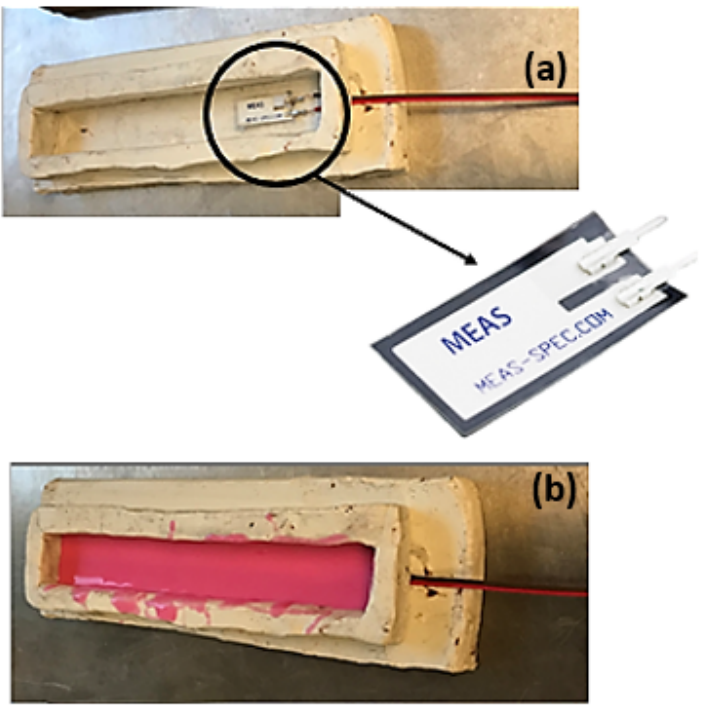
Figure 11. ( a ) mold filled with rubber-based mixture; ( b ) MEAS piezovibration sensor inside an empty